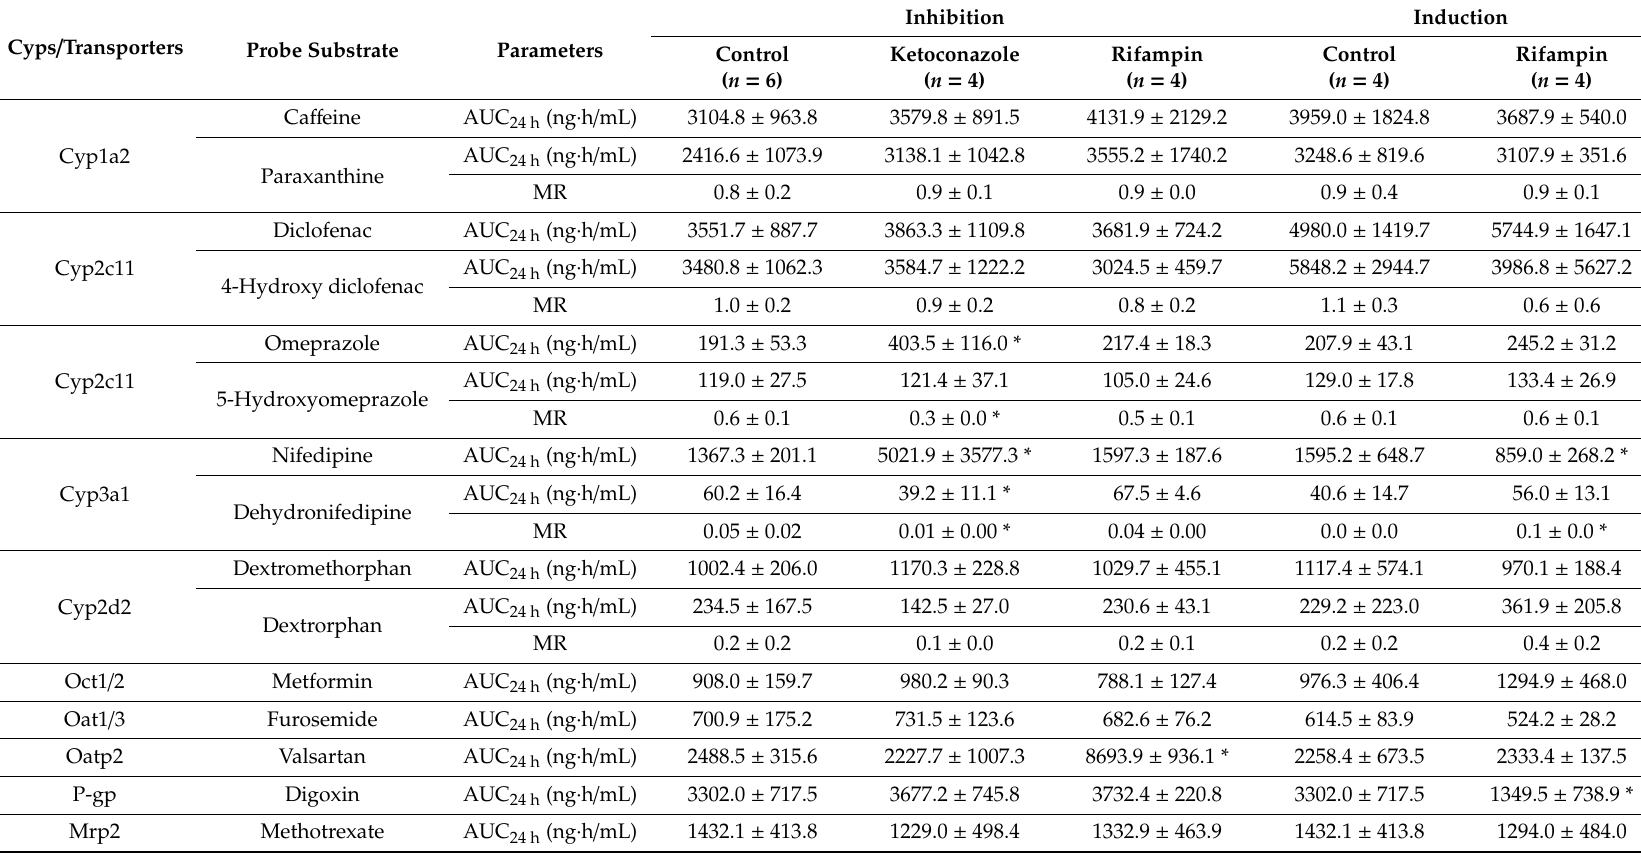
Table 8. The e ff ect of ketoconazole and rifampin on the pharmacokinetic parameters of probe substrates of the dual cocktail and metabolites.